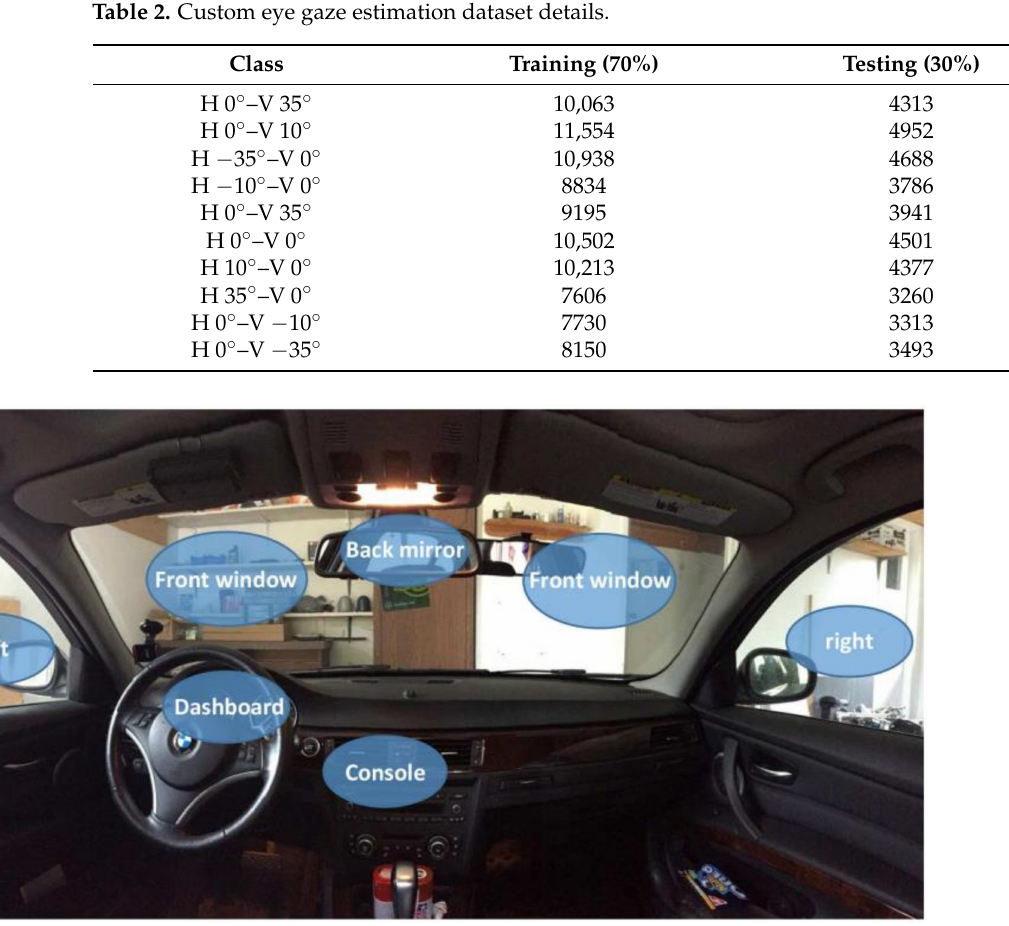
Figure 2. Selected face directional point of our